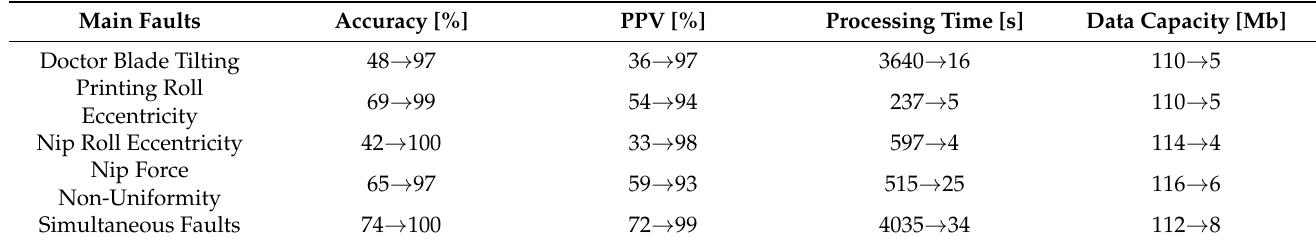
Table 21. Raw data and smart data diagnosis